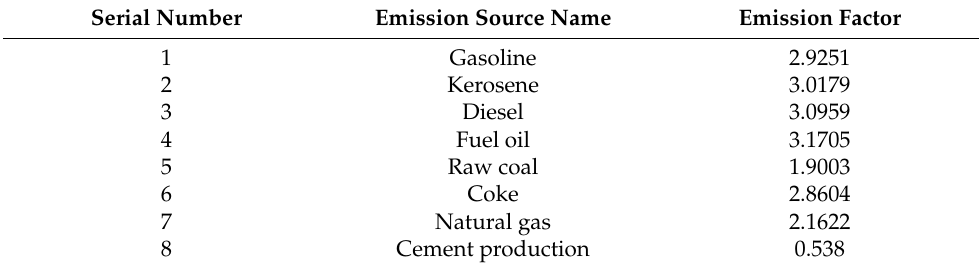
Table 3. Carbon emission